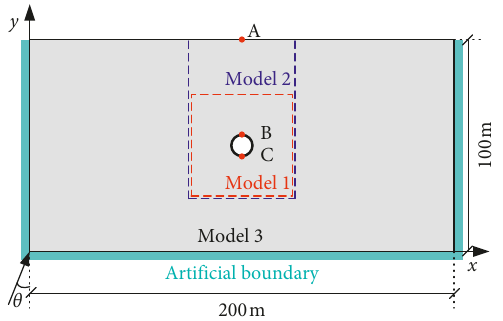
Figure 3: Homogeneous half-space model with an underground cavity.